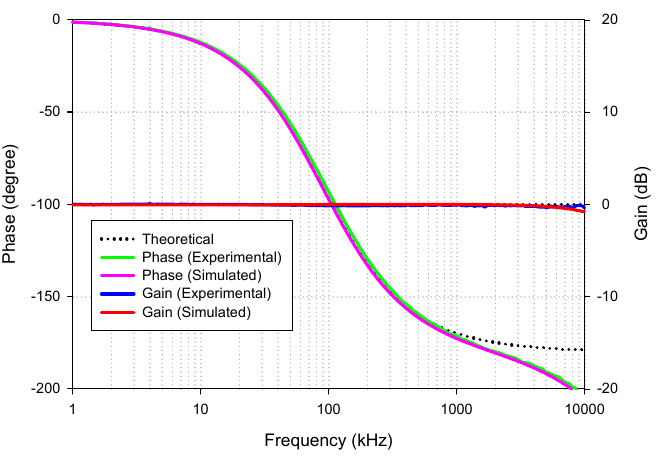
Figure 18. Frequency gain and phase response of AP − . The simulated and experimental AP − phase response with different I B values (67 μ A, 124.5 μ A, 245 μ A) is shown in Figure 19 where R 1 and R f remained at 1.2 k Ω . The results revealed that the phase of AP − was electronically controllable, as expected in Table 2. With these values of I B , the theoretical phase angles at f = 90 kHz were − 126.15°, − 90°, and − 56.62°, respectively. At the same time, the simulated phase angles from these I B values were − 124.22°, − 91.18°, and − 54.6°, respectively. The percent errors of the simulated phase angles from these I B values were 1.53%, 1.31%, and 3.56%, respectively. The experimental phase angles from these I B values were also − 121.63°, − 87.97°, and − 51.51°, respectively. The percent errors of the experimental phase angles from these I B values were 3.58%, 2.25%, and 9.02%, respectively.